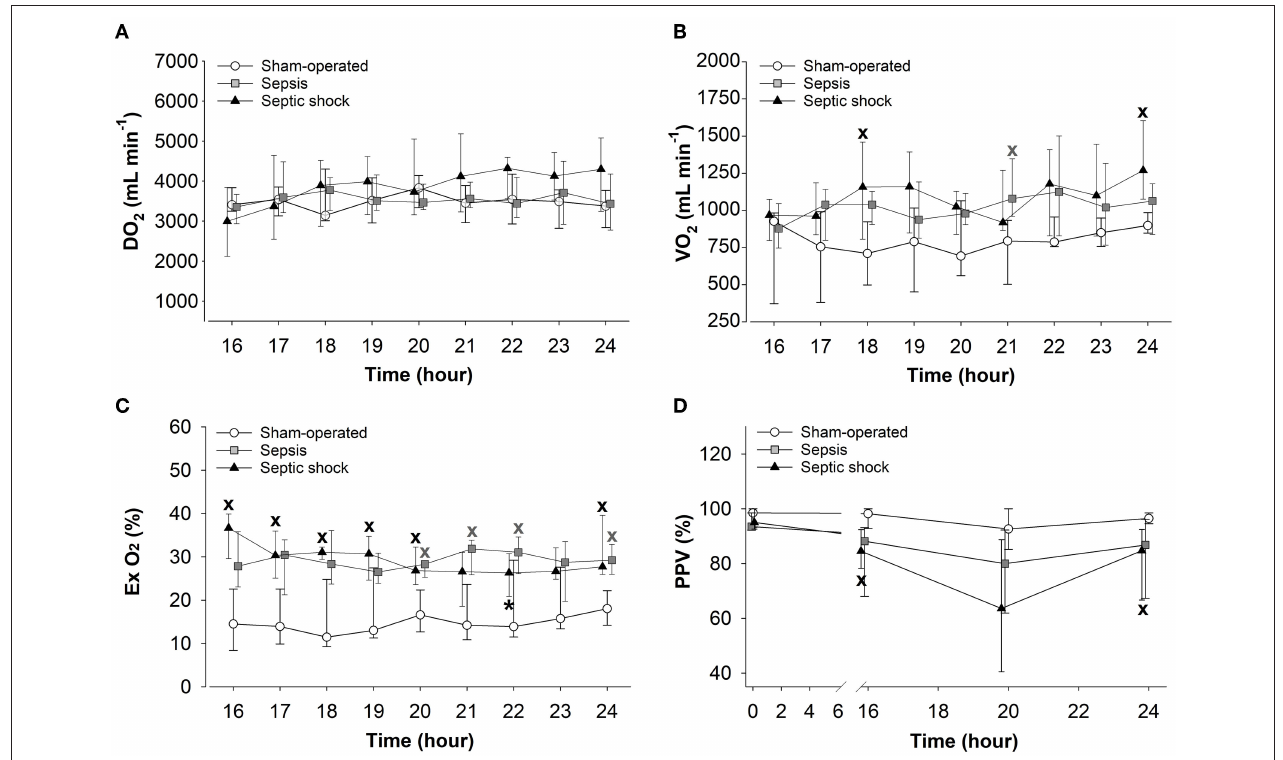
FIGURE 6 | Changes in oxygen delivery (DO 2 ) (A) , oxygen consumption (VO 2 ) (B) , oxygen extraction (Ex O 2 ) (C) , and the proportion of perfused vessels (PPV) (D) in the sham-operated group (open circles) and the sepsis (gray square) and septic shock subgroups (black triangle). The plots demonstrate the median values and the 25th (lower whisker) and 75th (upper whisker) percentiles. X P < 0.05 vs. sham-operated group; * P < 0.05 vs. t = 16h.